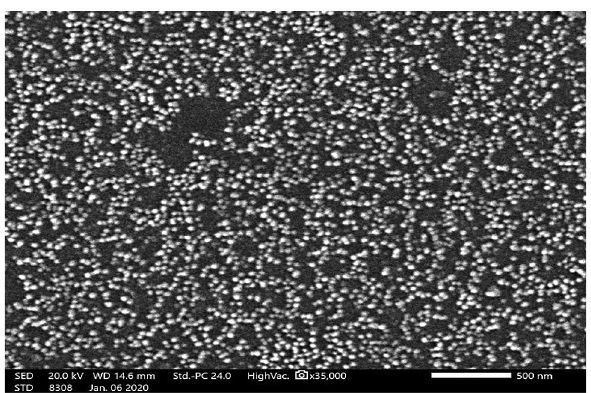
Figure 4. Scanning electron micrograph of Alk-ZnO NPs synthesized under optimum conditions at 35,000 ×